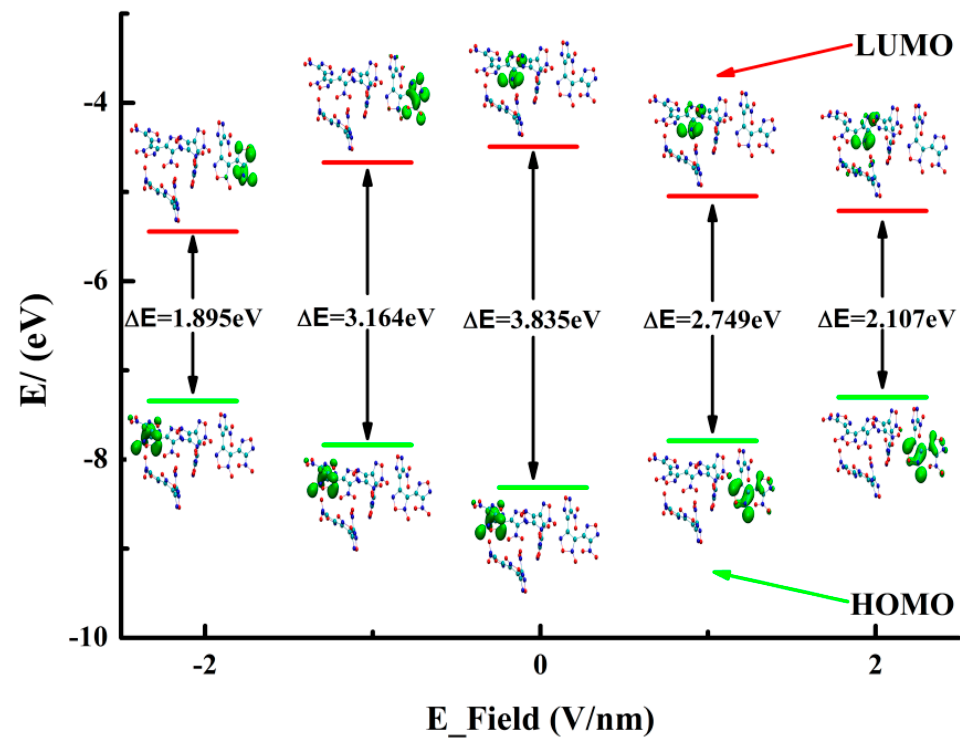
Figure 5. Variation trends for the Δ E HOMO-LUMO of DNTF under different E-fields.